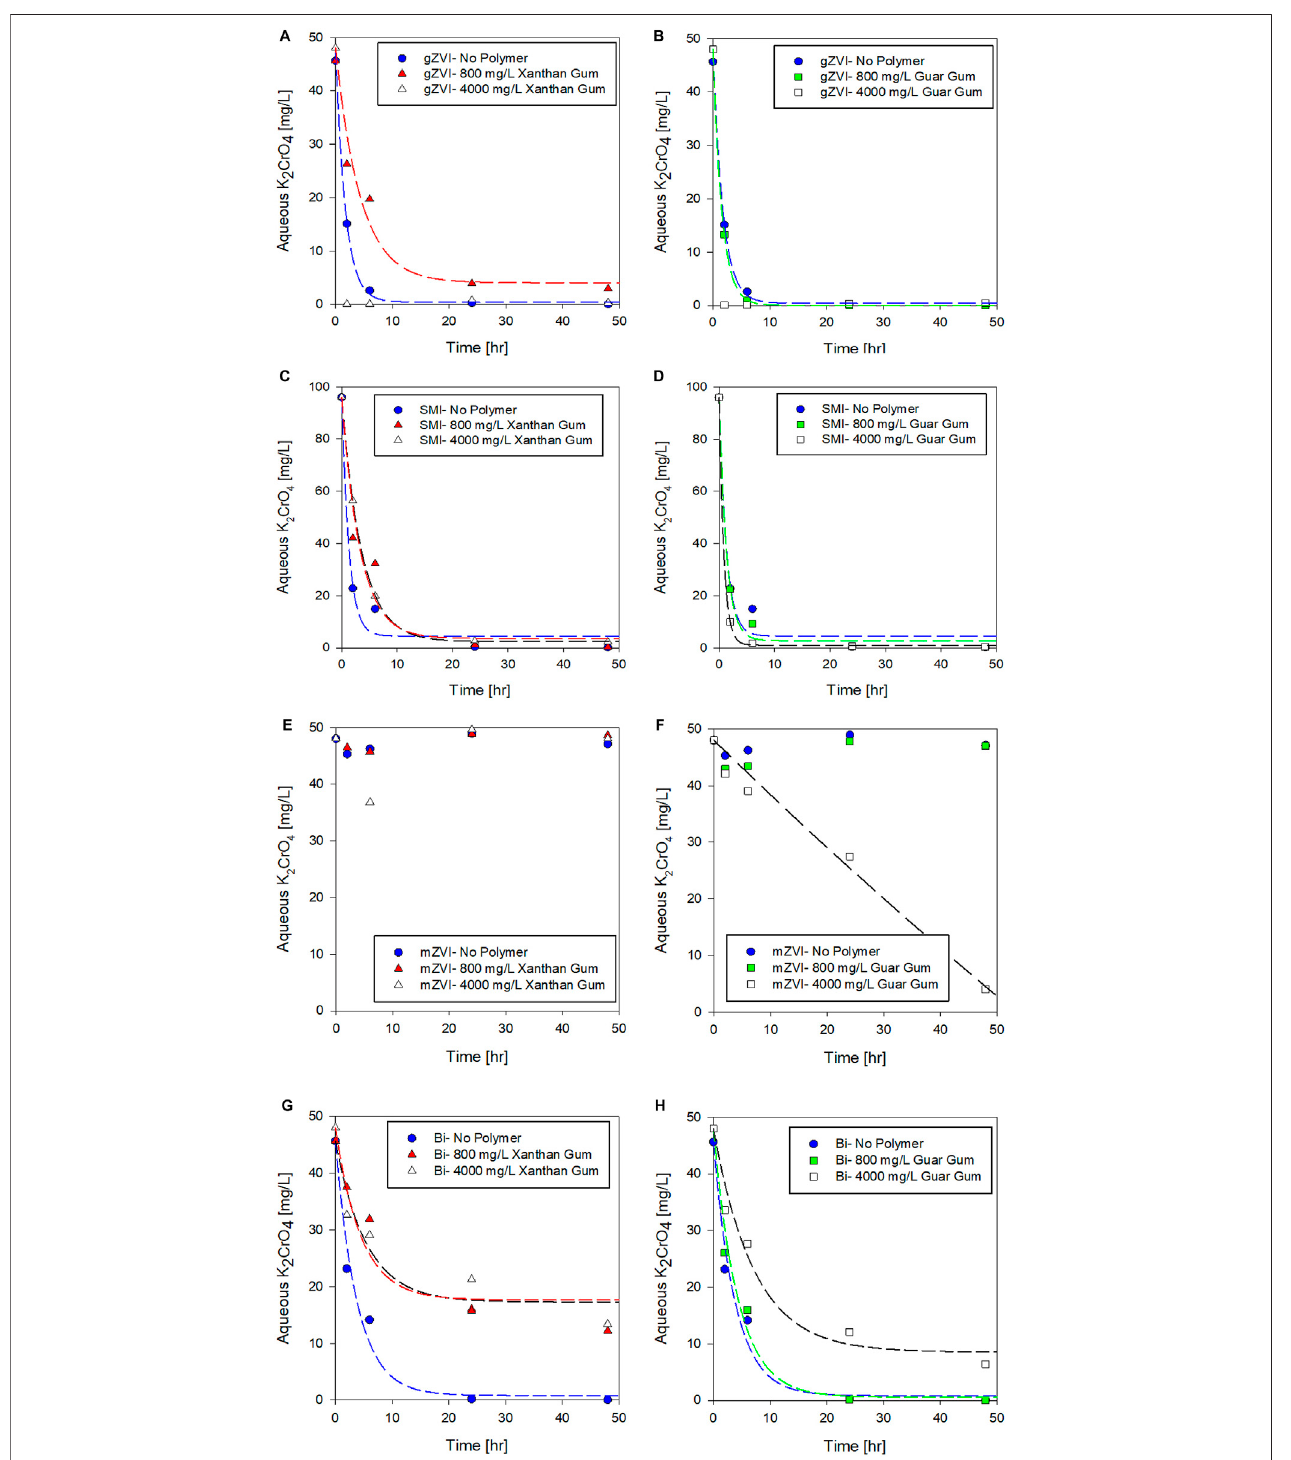
FIGURE 2 | Effect of Xanthan Gum and Guar Gum Concentration Effects on Reactivity of (A,B) gZVI, (C,D) SMI, (E,F) mZVI and (G,H) Bismuth, respectively. Symbols designate experimental data; lines indicate corresponding kinetic model fi ts ( Eq. 1 ). The relative error associated with experimental replicates ranged from 0 – 11% (average 5%).